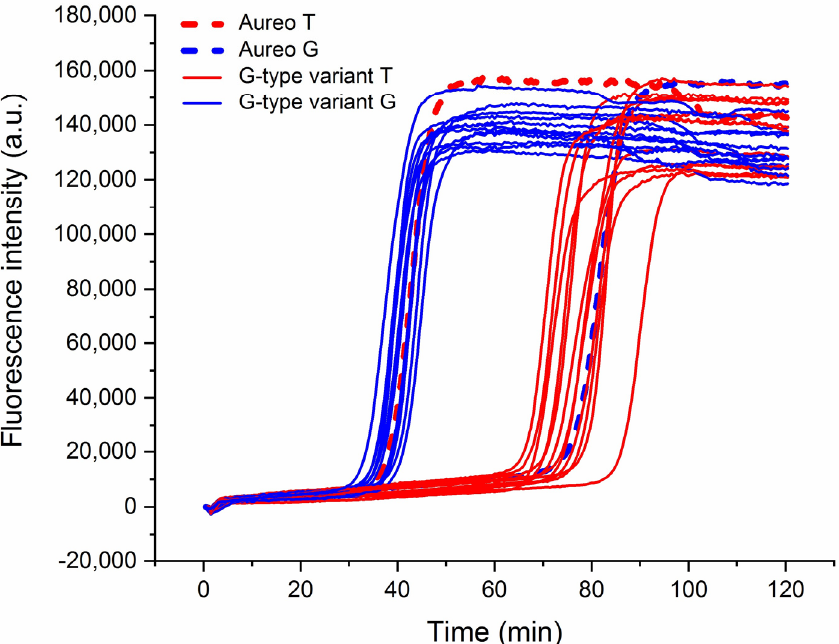
Figure 3. Real-time fluorescence detection of 13 genetic variants of wheat. LAMP reactions with loop primer T (red lines) and loop primer G (blue) of Aureo and G-type variants (Aureo: dashed lines). The time gap between all of the fast and all of the slow reactions was 35–40 min. All of the reactions were performed at 63 °C.